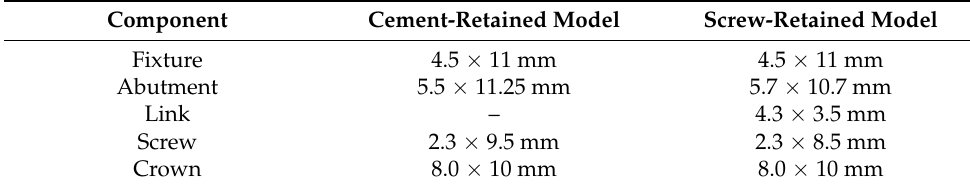
Table 1. Specification of the components used in the